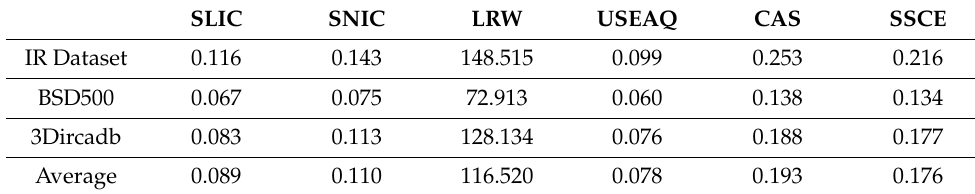
Table 2. Running times of different methods on three datasets (in seconds).